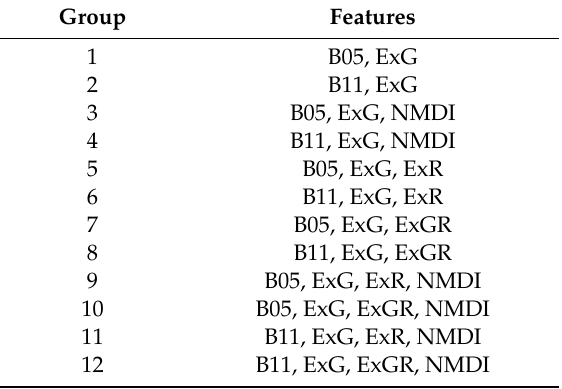
Table 5. Group of features to